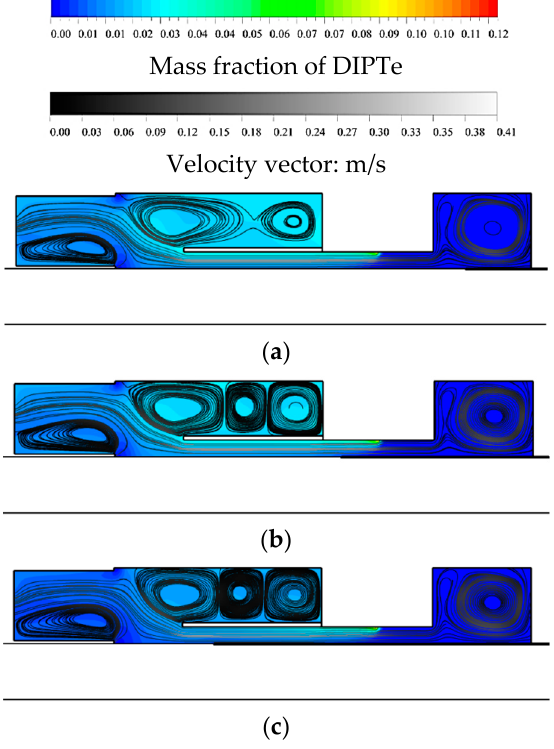
Figure 7. Velocity streamline coupled with mass fraction contour of DIPTe for CdTe growth under different time steps: ( a ) 60 s; ( b ) 180 s; ( c ) 300 s at a substrate temperature of 668 K.